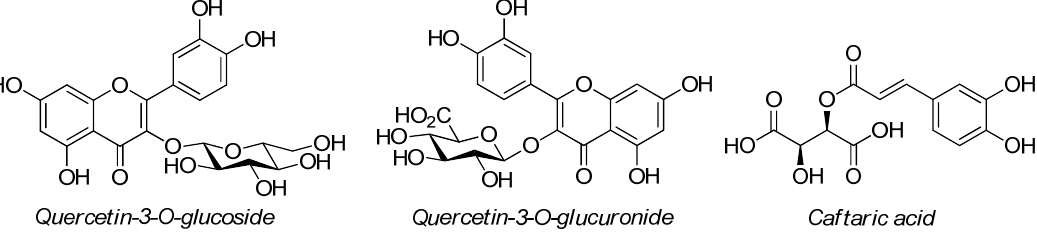
Figure 4. Chemical structures of flavonoid and non-flavonoid compounds identified by HPTLC fingerprint method.